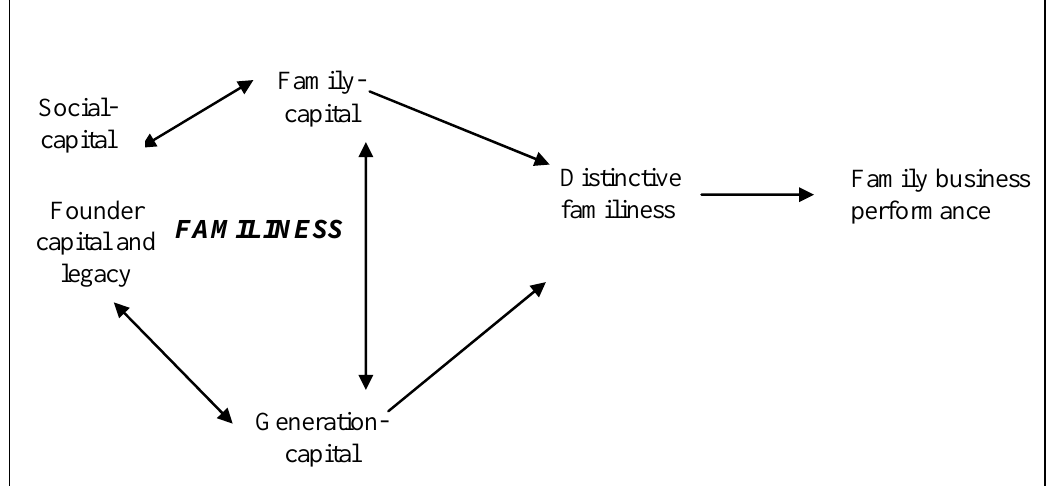
Figure 2: Framework of distinctive family business performance Source : Adapted from Venter, 2003: